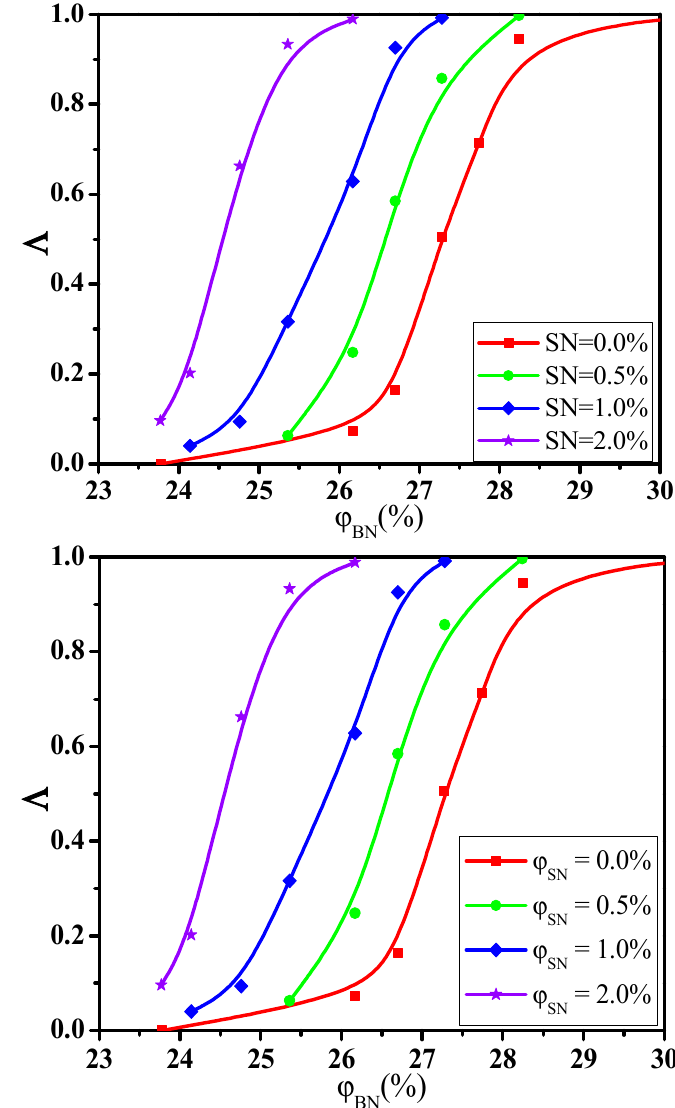
Λ ϕ Figure 7. Conductive probability with the concentration of big nanoparticles (BN) for three Figure 7. Conductive probability Λ with the concentration ϕ of big nanoparticles (BN) for three fixed concentrations of small nanoparticles fixed concentrations of small nanoparticles (SN).